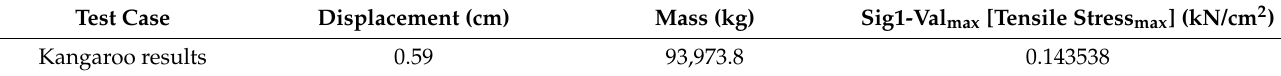
Table 4. FEA results Kangaroo solver